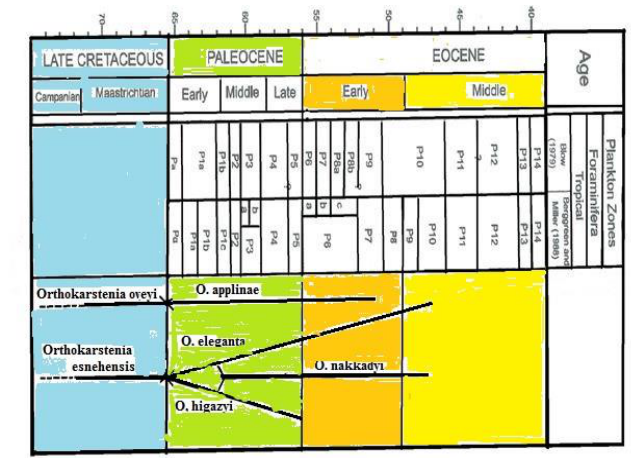
Figure 6: The proposed phylogenic lineage of the Orthokarstenia members in the Southern